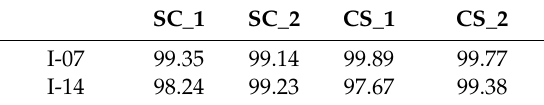
Table 4. Recognition accuracy of fault labels I-07 and I-14 using multi-attention mechanisms.